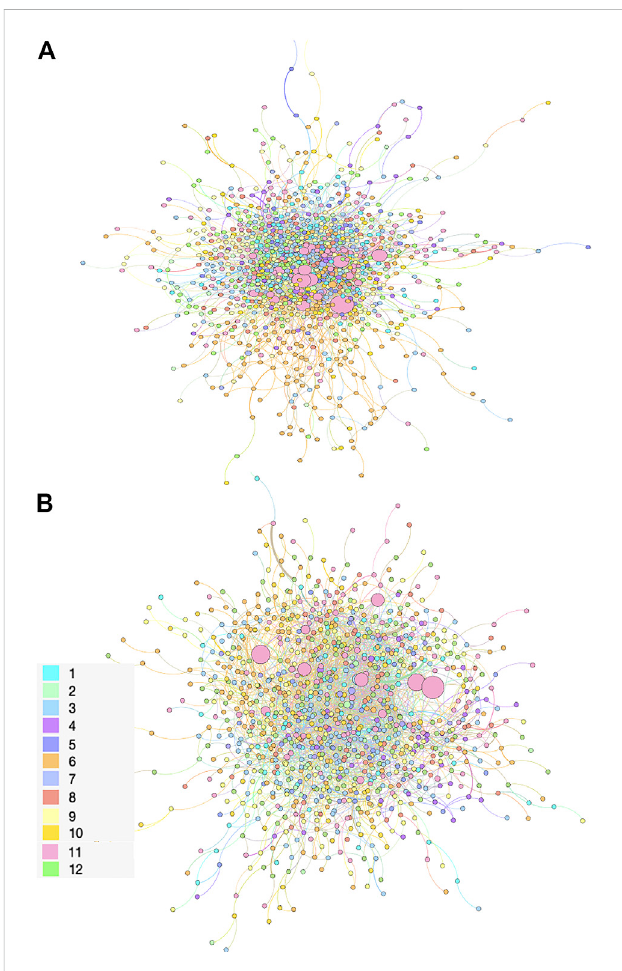
FIGURE 4 Con fi guration of board networks (A) in 2002 (normal period) and (B) in 2008 (tranquil period). A node represents a company, and an edge represents a link by interlocking directorates between boards. Node size means the total asset of the company. Node colors indicate the industrial groups of boards: (1) NoDur, (2) Durbl, (3) Manuf, (4) Enrgy, (5) Chems,(6)BusEq,(7)Telcm,(8)Utils,(9)Shops,(10)Hlth,(11)Money,and (12)